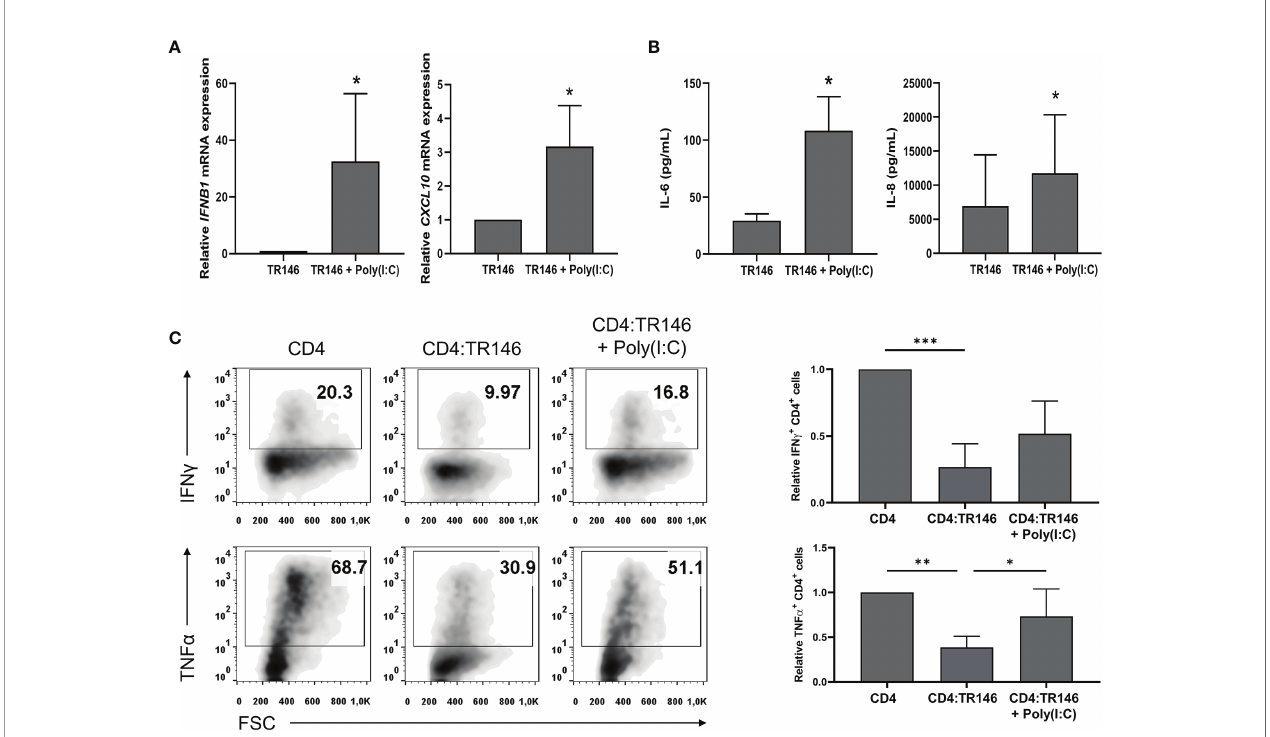
FIGURE 5 | Poly(I:C) stimulates cytokine expression in TR146 cells and partially prevents T cell inhibition by OECs. TR146 cells were fi rst stimulated or not with 20 m g/mL poly(I:C) for 4 hours and then washed twice with PBS. (A) IFNB1 and CXCL10 mRNA relative expression was evaluated in TR146 cells by RT-qPCR. (B) TR146 cells were cultured for other 48 hours and IL-6 and IL-8 release was measured by ELISA in cell-free supernatants. (C) TR146 cells were co-cultured with anti-CD3/CD28-activated CD4 T cells for other 48 hours and re-stimulated with PMA and ionomycin for 4 hours before analysis. Data were obtained by fl ow cytometry and shown as the percentage of IFN g and TNF a -producing CD4 T cells from a representative experiment (density plots) and relative to CD4 T cells alone when considering all experiments (bar graphs). FACS gatings were adjusted by the use of mouse anti-IgG-PE and anti-IgG-APC antibodies. Bar graphs display mean values with SEM error bars. Statistically signi fi cant differences were obtained applying two-tailed Student ’ s t tests for independent samples (A, B) or ANOVA tests (C) . Signi fi cant differences (p < 0.05, p < 0,01 and p < 0.001) are noted as “ * ” , “ ** ” and “ *** ” , respectively. Data were obtained from a total of three independent experiments using samples from different